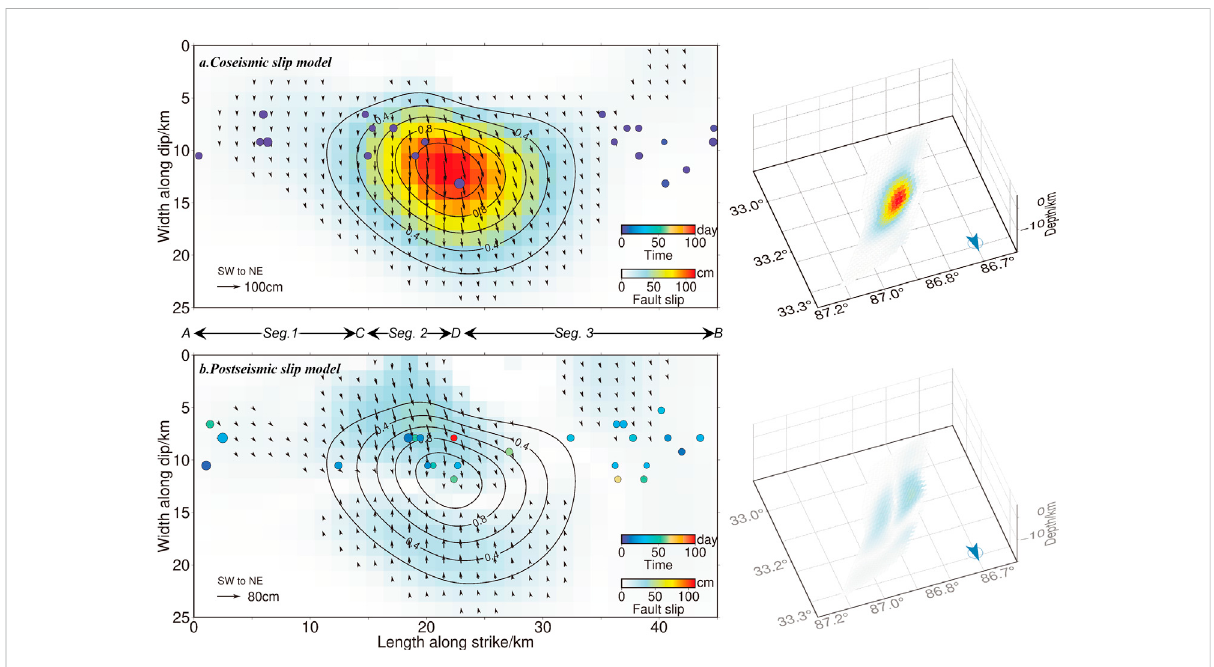
FIGURE 6 Two and three-dismension coseismic and postseismic slip models of the 2020 Nima earthquake. Color circle points indicate the initial 8-day and latter aftershocks, respectively. Characters (A,B) inidicate the faulting trace in Figures 2, 9,